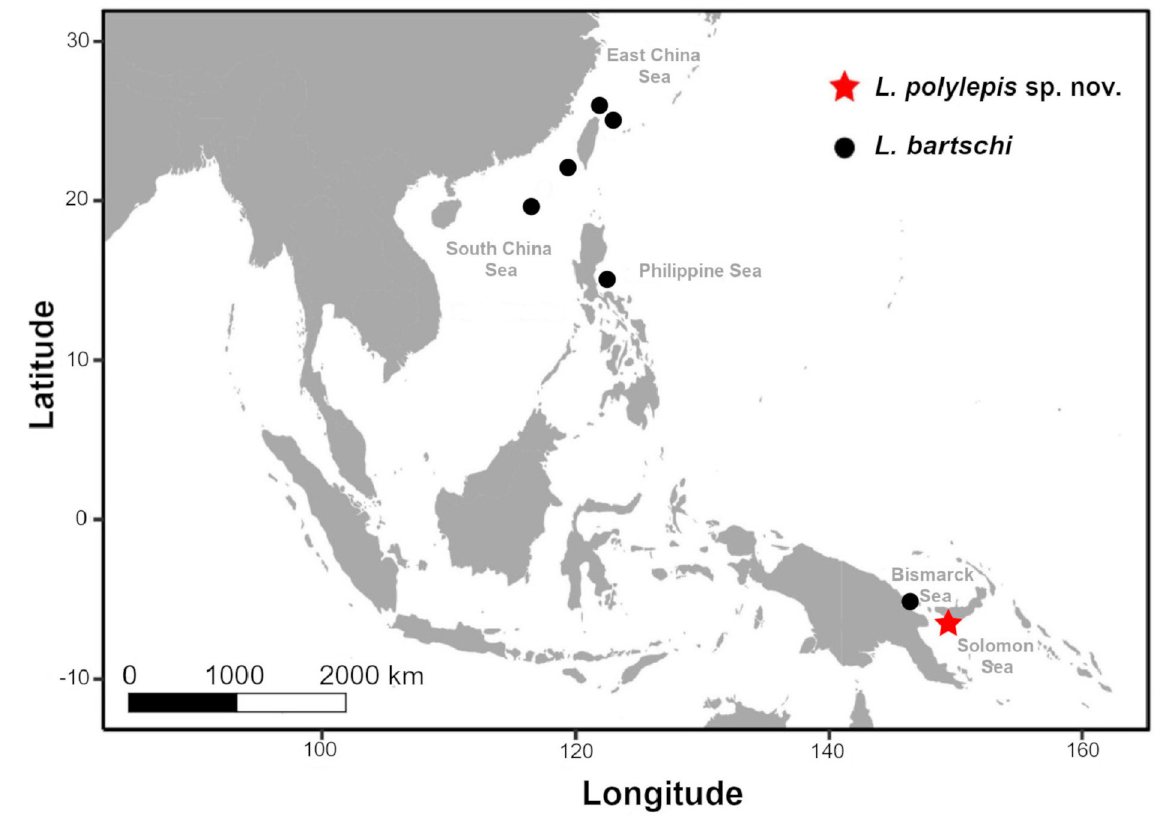
Fig. 1. Distribution of Luciobrotula polylepis sp. nov. (red star) and L. bartschi Smith & Radcliffe 1913 (solid circles) based on specimens examined in this